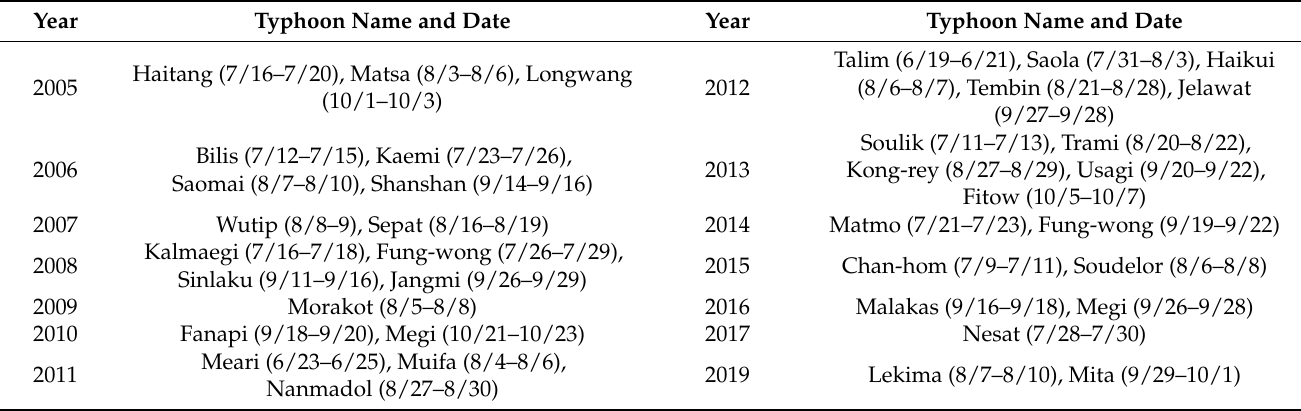
Figure 6. Location of the study area, including the meteorological stations and buoys (right part). Dotted lines represent the position of shelf slope, ridges, and troughs (left part; reprinted by permission from Springer Nature Customer Service Centre GmbH (the Licensor): Springer Nature, Journal of Oceanography, Lin et al. [83], 2000. Table 1. Typhoon data from 2005 to